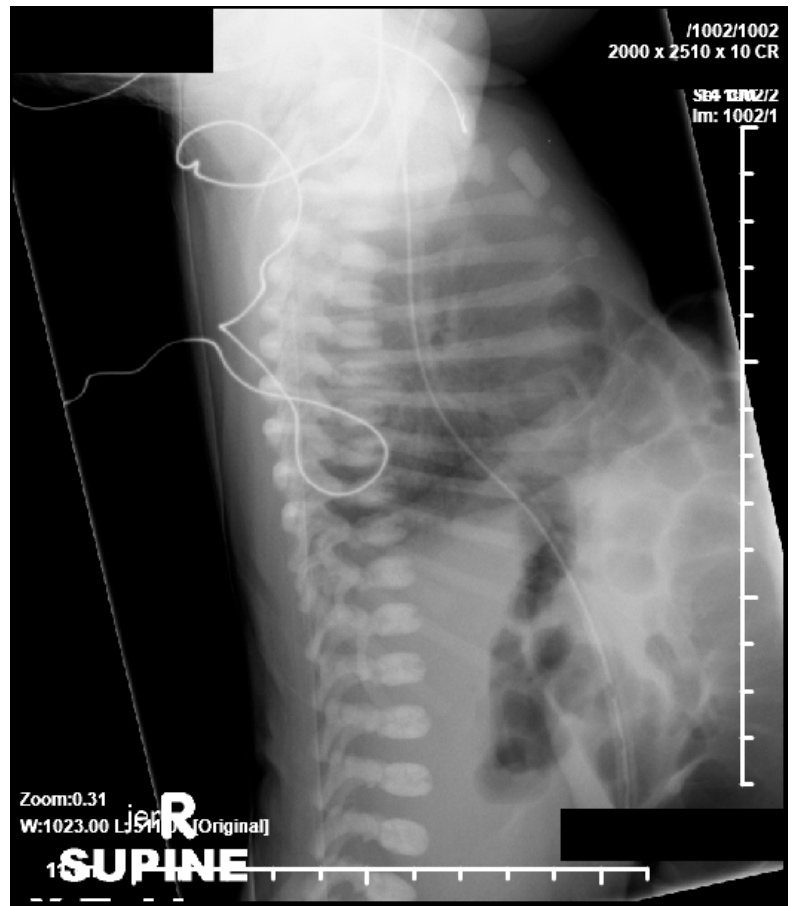
Figure 2. Lateral radiograph showing absence of lower part of sternum, large omphalocele, anterior diaphragmatic herniation, and suggestion of pulmonary hypoplasia.